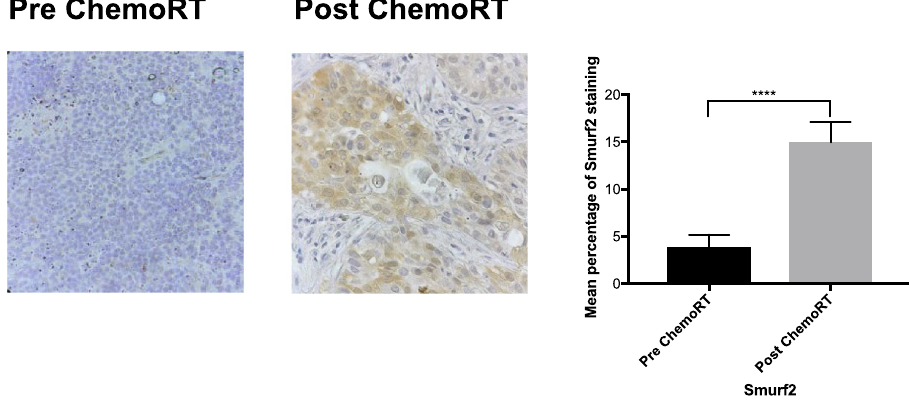
Figure 4. ChemoRT upregulates Smurf2 protein expression in tumor cells in patients with stage III NSCLC. Smurf2 IHC revealed significantly higher Smurf2 protein expression in the post-chemoRT-patient lung tumor samples (n = 8) than in the pre-chemoRT tumor samples (n = 7). Representative examples are